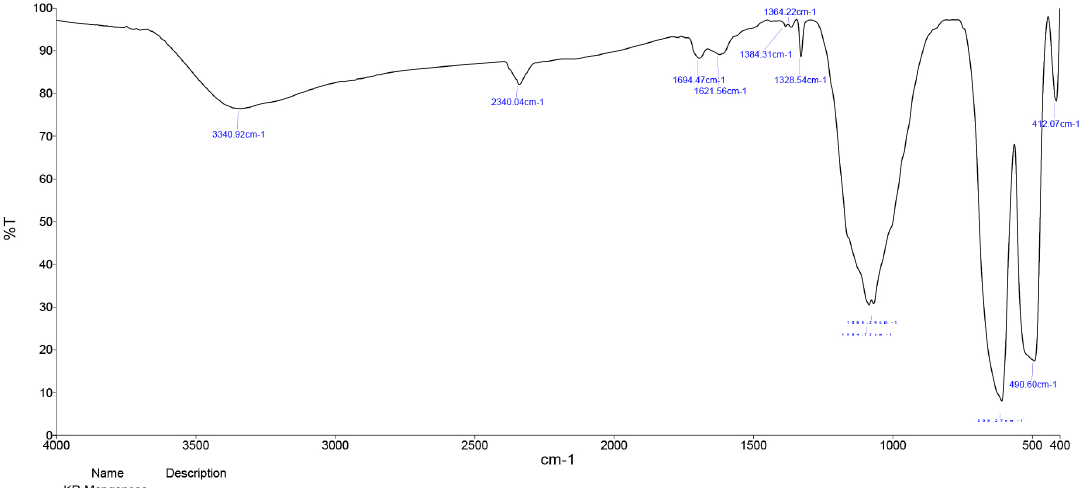
Fig. 5 . represents the FTIR spectrogram of the MnO nanoparticle